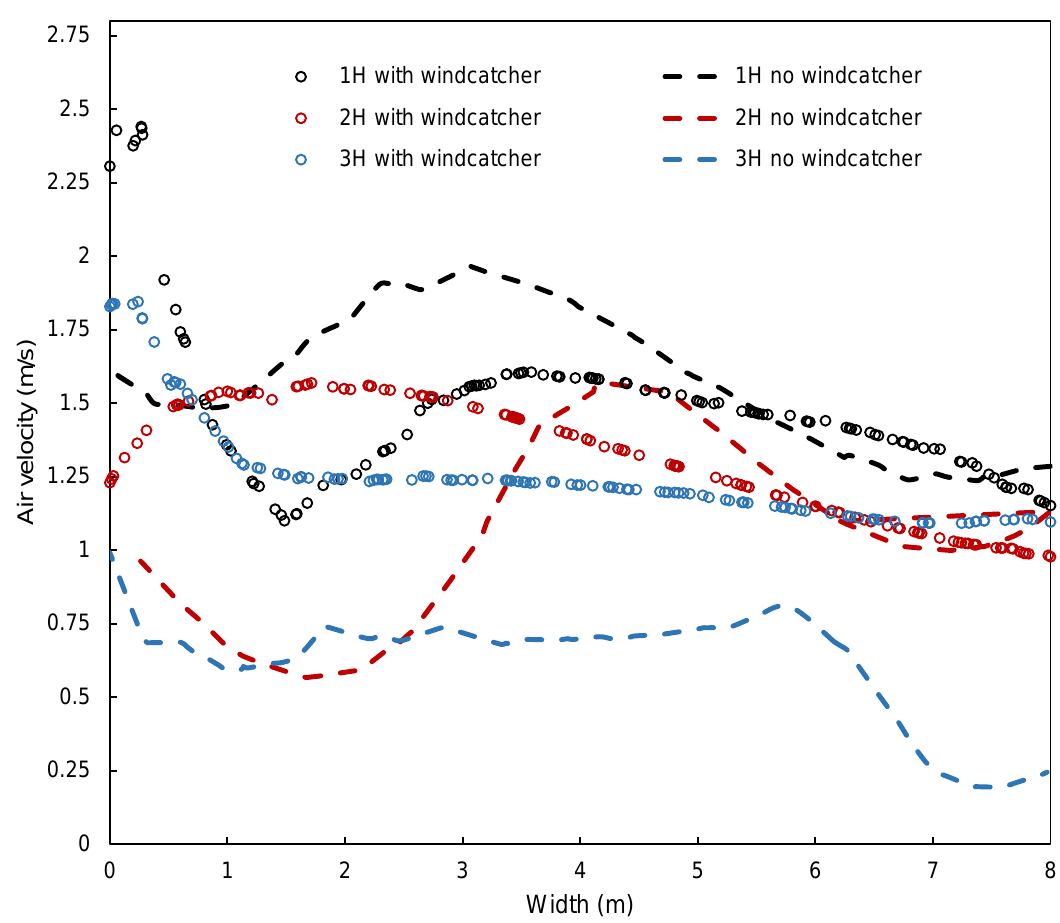
Figure 23. Simulated air velocity along the centre line of the greenhouse at height z = 0.8 m for the greenhouse with cross-flow or windcatcher ventilation (U H = 4.4 m/s).